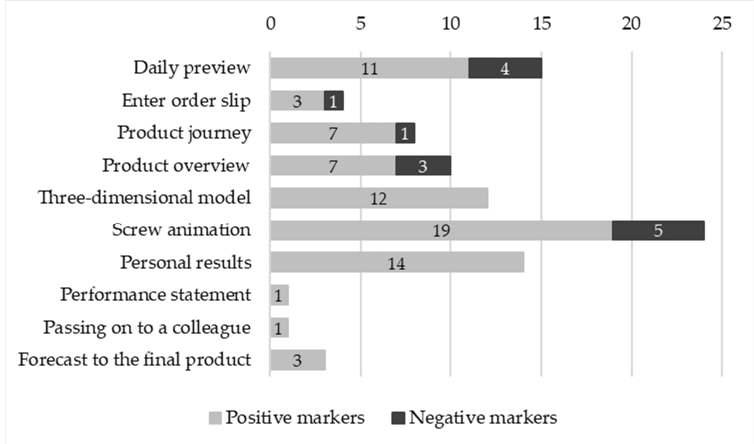
Figure 2. Amount of valence markers for positive UX design concepts.